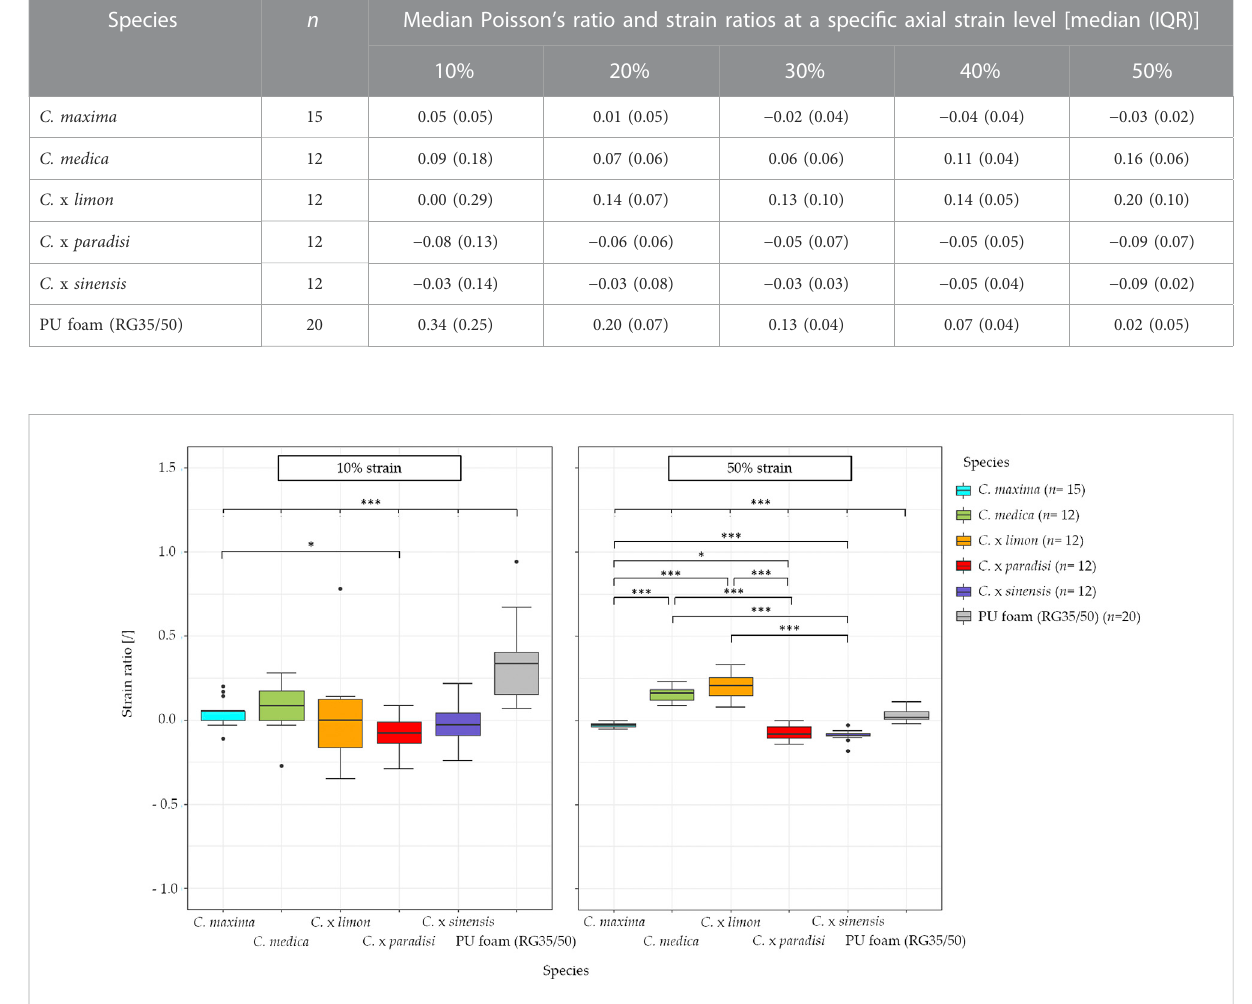
FIGURE 4 Comparison of the Poisson ’ s ratio and the strain ratio for the tested Citrus species: pomelo ( C. maxima ), citron ( C. medica ), lemon ( C. x limon ), grapefruit ( C. x paradisi ), orange ( C. x sinensis ), and for PU foam at a strain level of 10% and 50% compression. The values are calculated with the manual image correlation method (MIC). All samples of Citrus spp. Are highest signi fi cant different from the ones of the PU foam